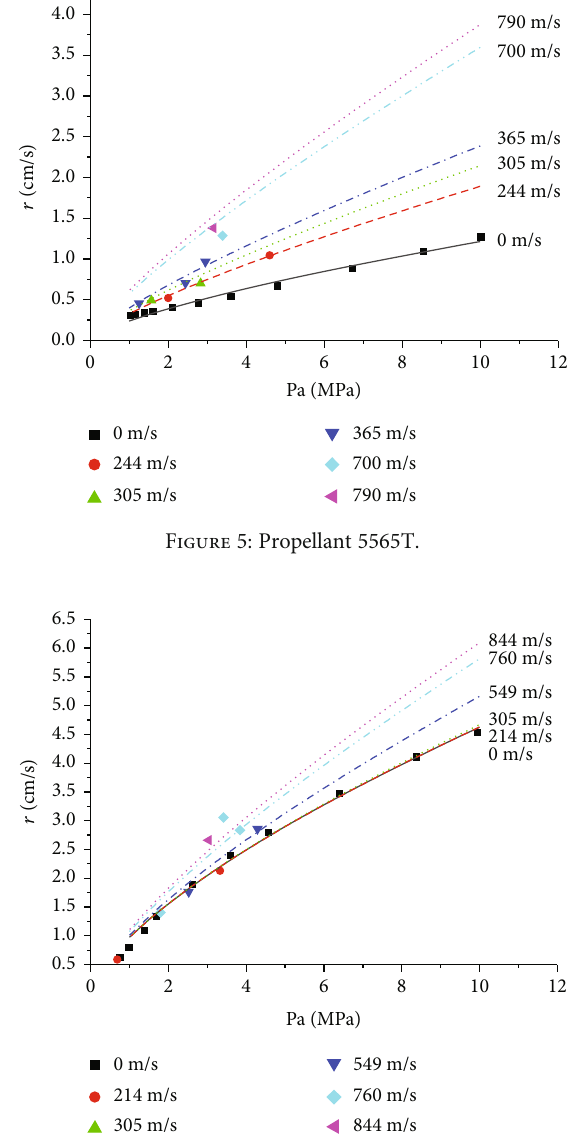
Figure 6: Propellant